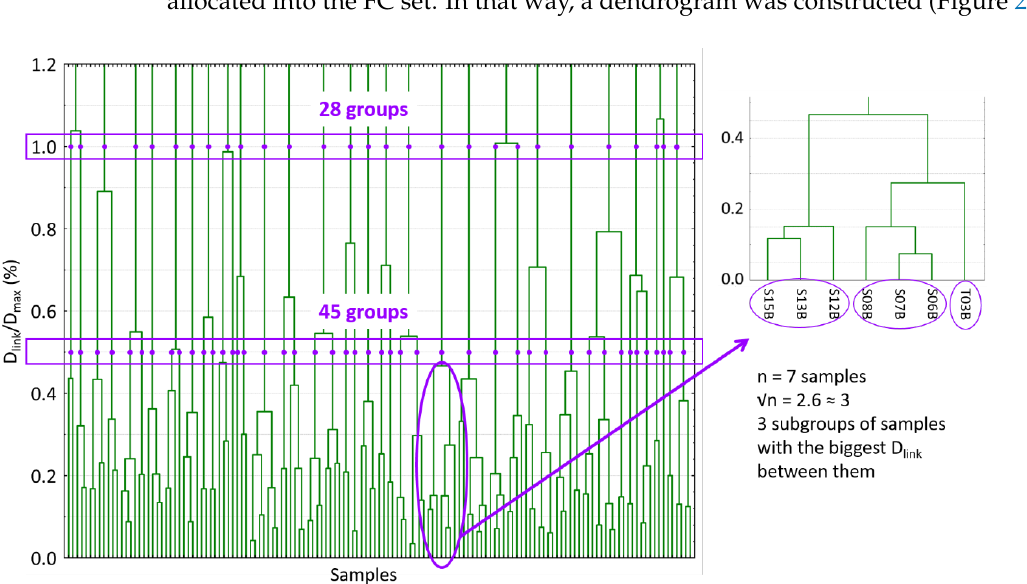
√ n samples of one group is also shown as an example. D link : √ n:square root of the number of samples in a